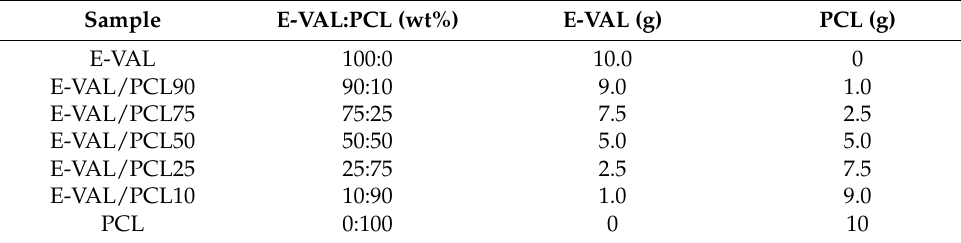
Table 1. Preparation conditions of the E-VAL/PCL blends in